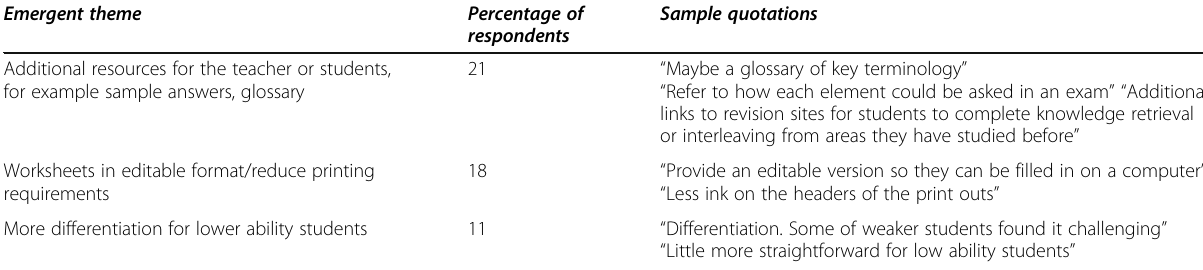
Table 5 Emergent themes in the content analysis for response data to the question: “ How could the resource packs be improved? ” ( n = 138). Only themes with > 5% respondents are shown Emergent theme Percentage of Sample respondents